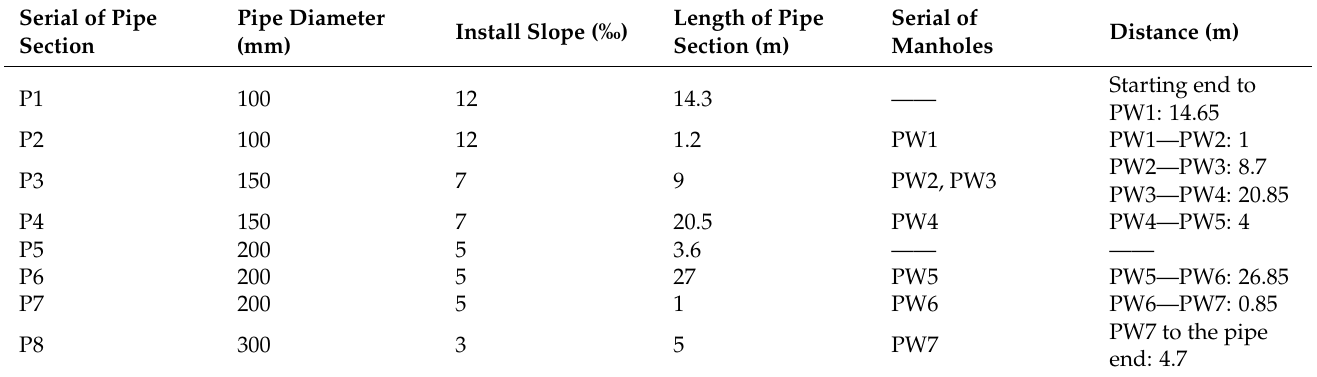
Figure 2. Pilot-scale experimental system for sewer blockage identification. ( a ) Pilot-scale experimental device of sewer blockage identification. ( b ) Experimental process of sewer blockage identification. Table 1. Parameters of the sewer and spacings between manholes.